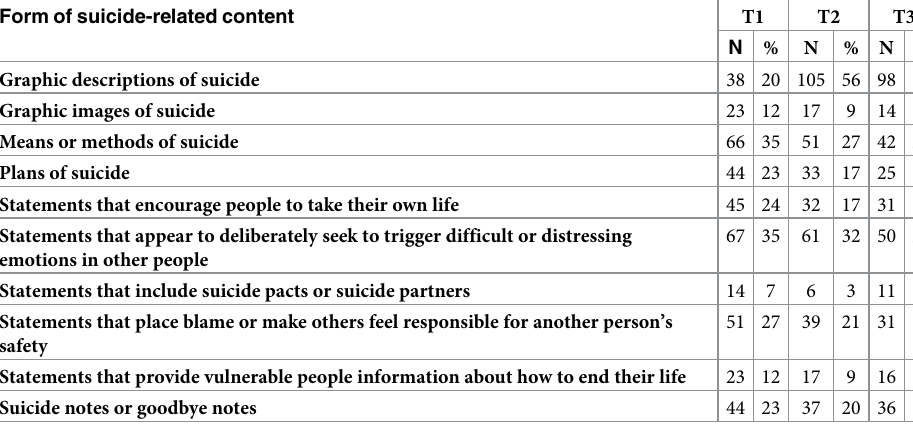
Table 6. Forms of suicide-related social media content seen by participants across